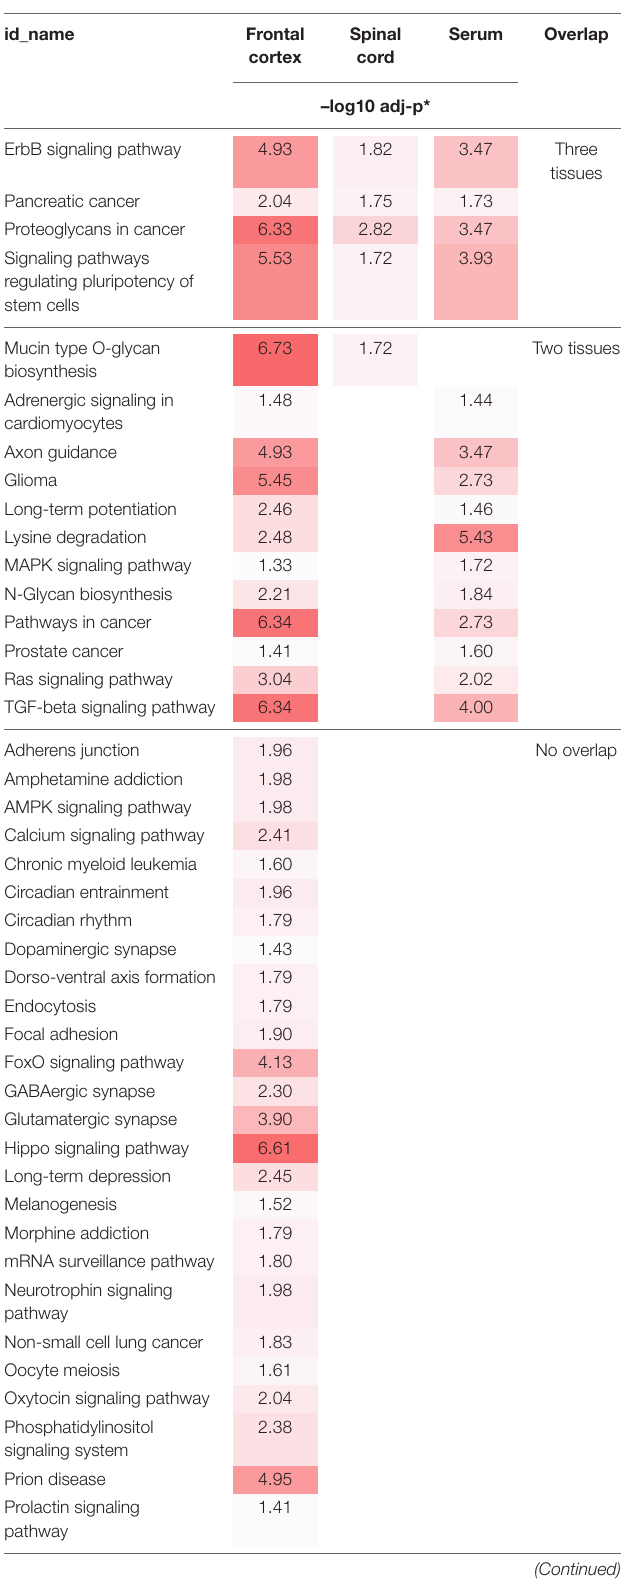
TABLE 2 | Individual and overlapping enriched KEEG Pathways of ALS DEmiRNA predicted targets from frontal cortex, spinal cord, and